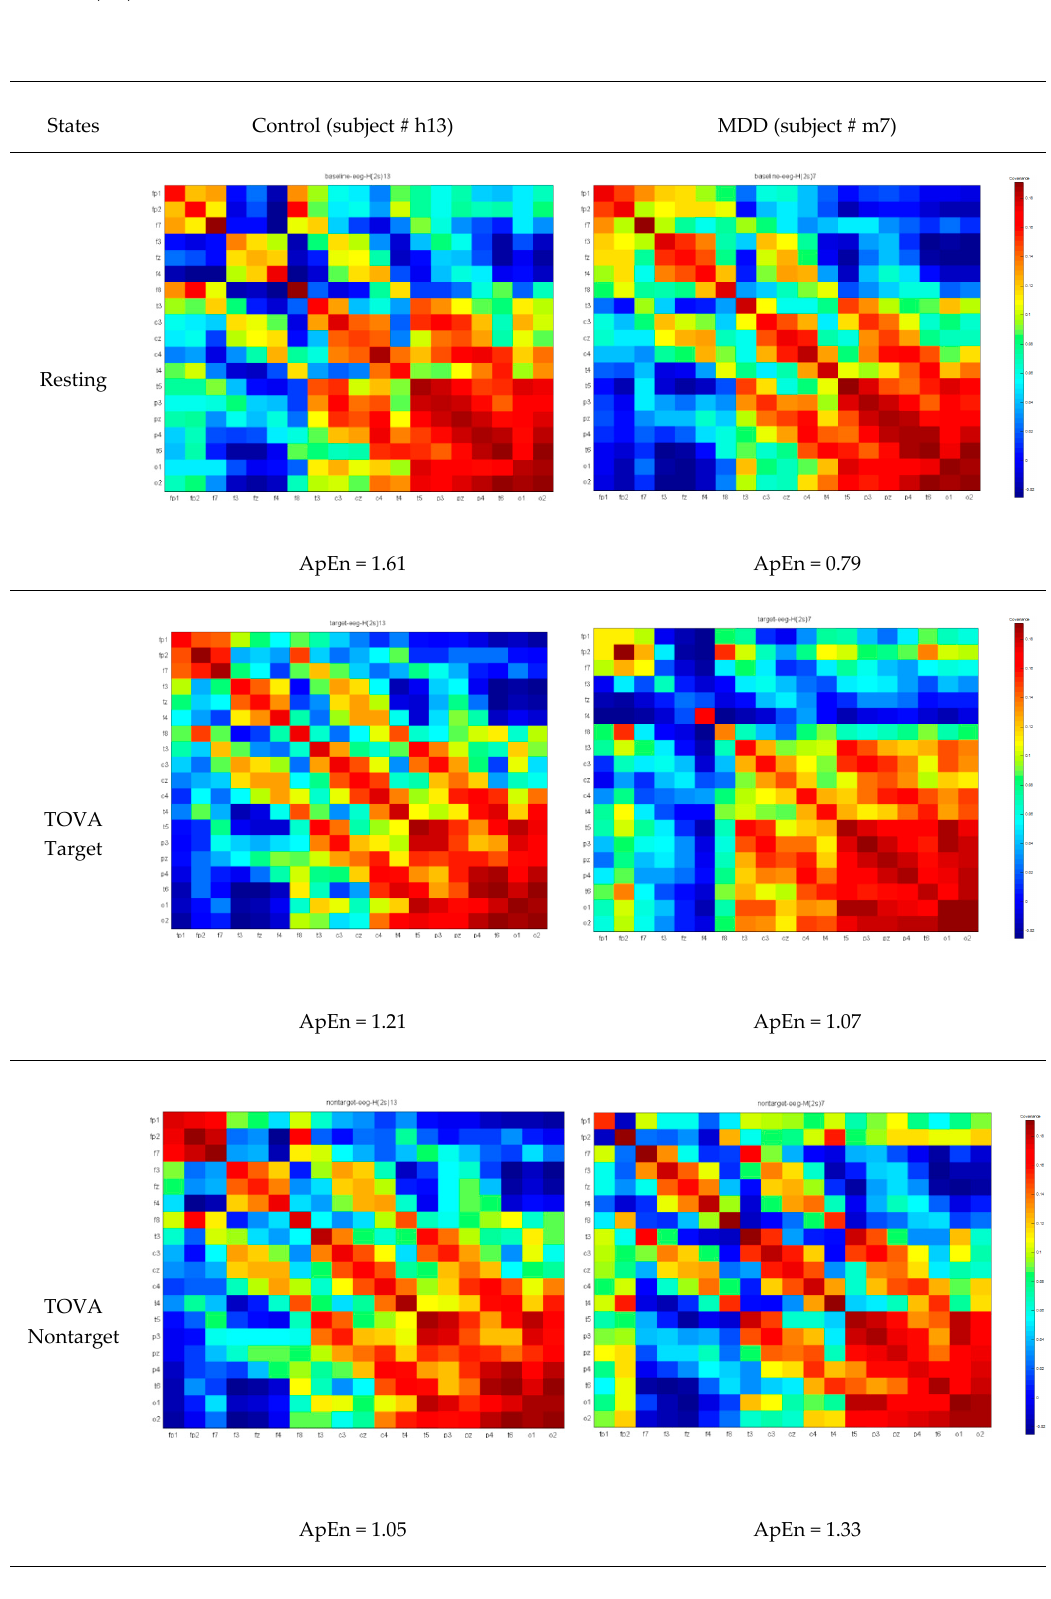
Figure 5. Common covariance matrix images of approximate entropy (ApEn) of participant #h13 in the control group and participant # m7 in the MDD group. Color pixels represent the covariance values.